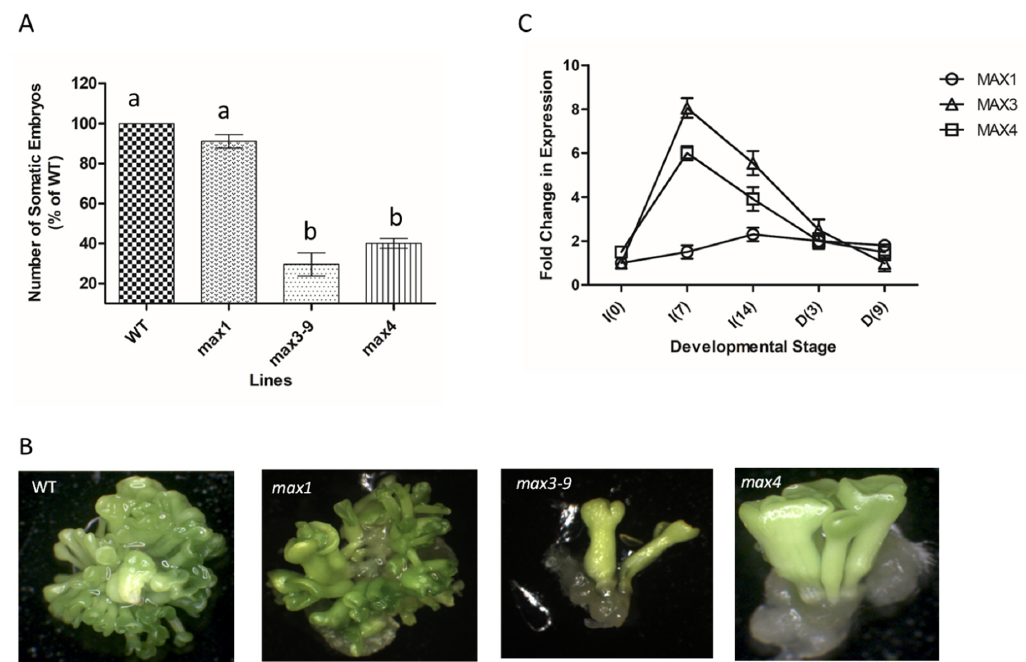
Figure 2. ( A ) Number of somatic embryos produced by WT tissue and max1 , 3–9 , and 4 tissues. Values are means ± SE of three biological replicates ( n = 15). Letters on bars indicate statistically significant differences ( p < 0.05). ( B ) Micrographs showing the number of fully developed somatic embryos from tissue in ( A ). ( C ) The fold change in expression level of MAX1 , 3–9 , and 4 at different time points during the induction ( I ) and developmental ( D ) stages of embryogenesis. Values are means ± SE of three biological replicates ( n = 15).